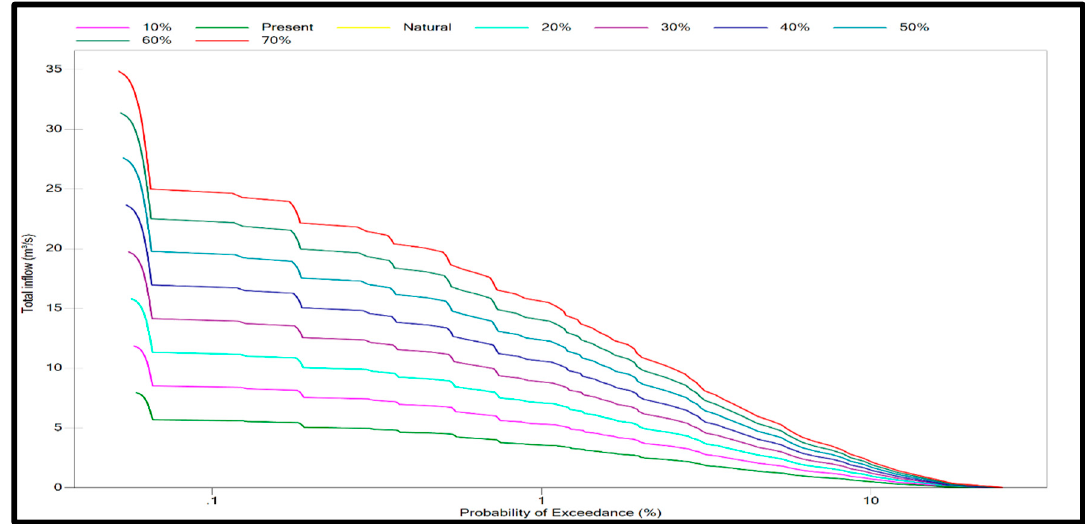
Figure 6. Effects of urbanization on Flow Duration Curve (FDC) in the Myponga catchment.